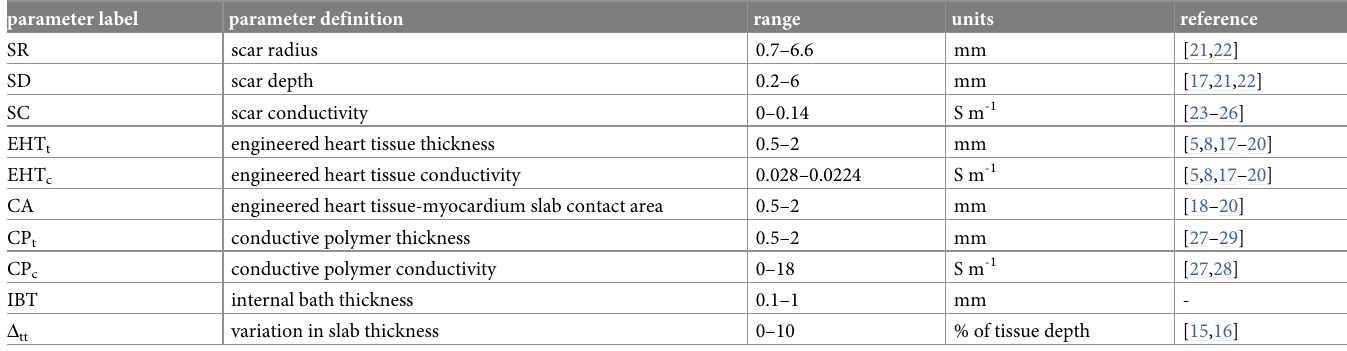
Table 1. Parameter ranges from literature for the 10 model input parameters. parameter